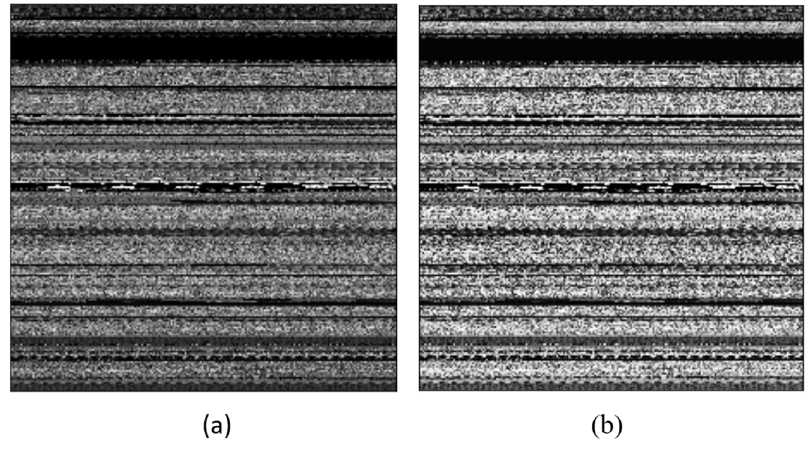
Figure 6. Images before ( a ) and after ( b ) the implementation of CLAHE. The difference between the histogram equalization of the image before and after the use of CLAHE is shown in Figure 7a,b. CLAHE changes the pixel values of the image from high to low. It is an extension of Adaptive Histogram Equalization (AHE) that modifies the computation of enhancement by imposing a user-specified level on the height of the local histogram. Thus, augmentation is minimized in extremely uniform portions of the image to prevent enhancing noise and reduce the impact of edge shadowing. High-intensity values (black color) are converted into lower-intensity values (grey).